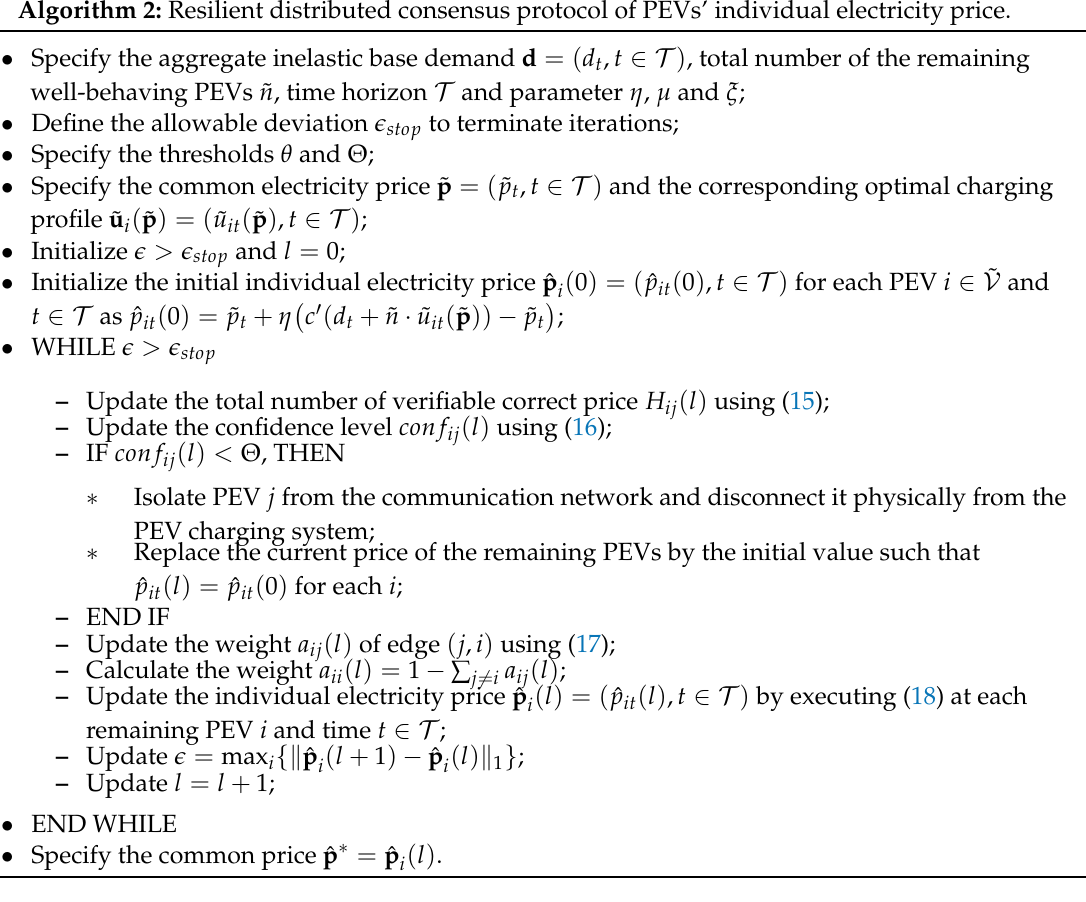
Algorithm 2: Resilient distributed consensus protocol of PEVs’ individual electricity